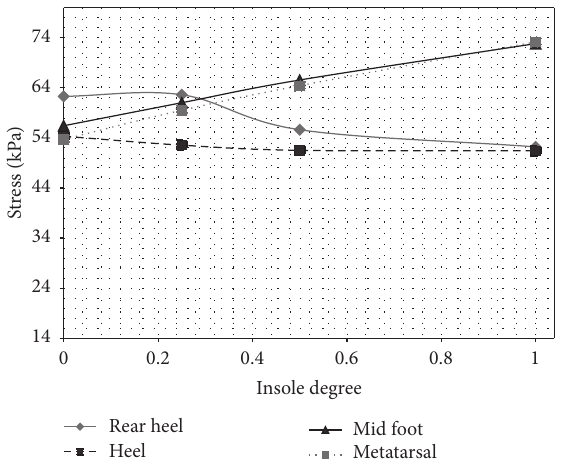
Figure 6: Variation of maximum stress value by changing the degrees in metatarsal, mid foot, and heel regions for flat insole. Increase of insole degree (or the heel height) does not necessarily reducethemaximumstressinfoot;therecommendedrangeisabove 1 ∘